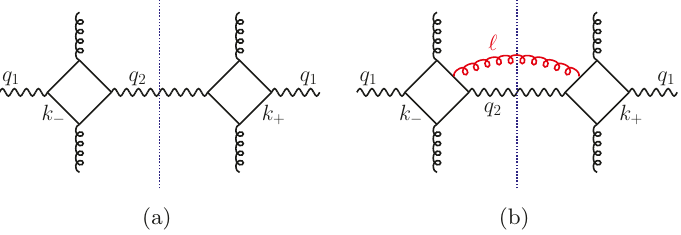
Figure 11 . (a) Hard scattering part of the double box graph. (b) Higher-order correction giving rise to a large DGLAP logarithm in the DPS